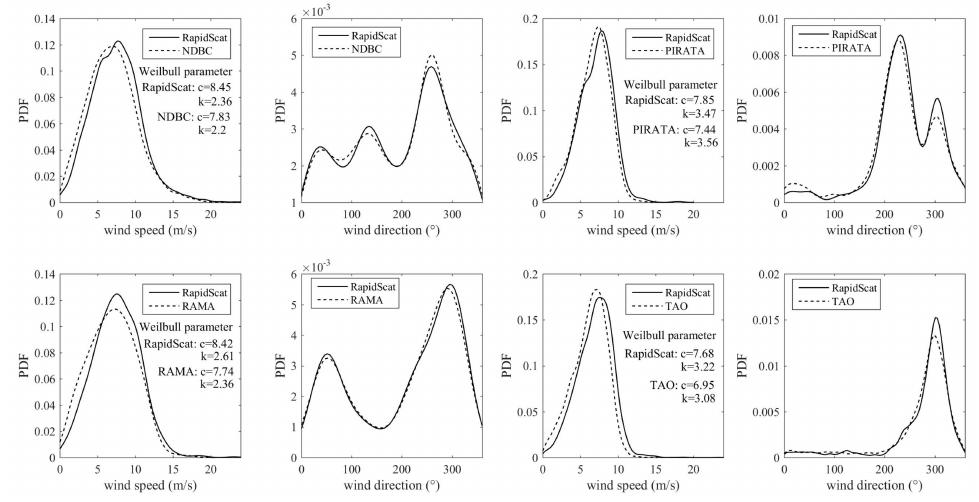
Figure 8. PDFs of RapidScat and buoy wind speeds and directions in the bin of 1 m/s and 10 ◦